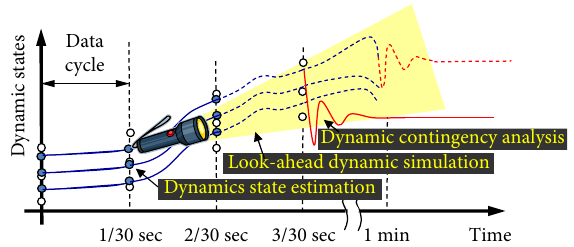
Fig. 8 Dynamic state estimation is foundational for real-time stability assessment of complex power systems.